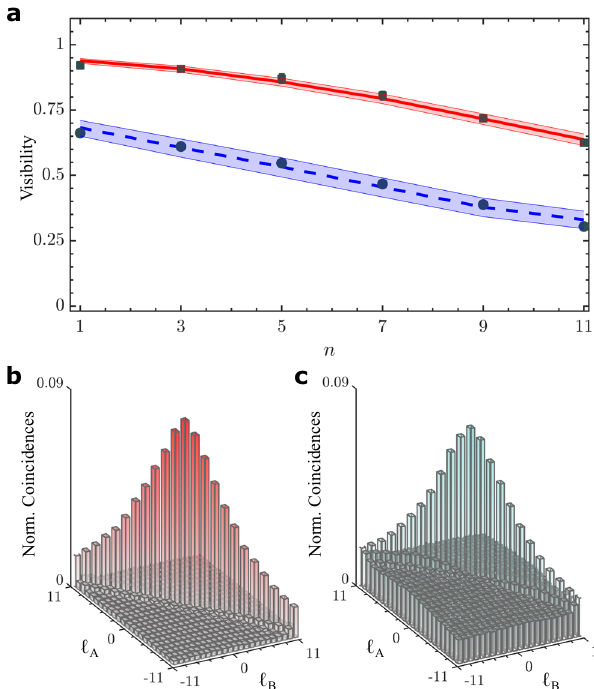
Fig. 3 Experimental visibilities and modal spectrum. a Visibility measurements for low (top solid line) and high noise (bottom dashed line) levels. The points are the experimental visibilities, while the lines correspond to the fi tted values of dimension and purity. Measured spiral spectrum for the b low and c high noise levels. The shaded area corresponds to the uncertainty in the fi t (standard deviation).